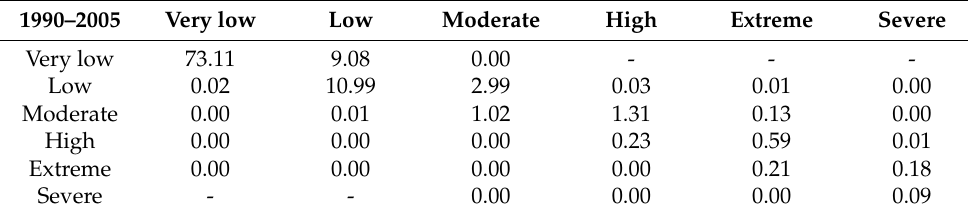
Table 4. The transfer matrix of SEI in the QLB in 1990–2005 (%).